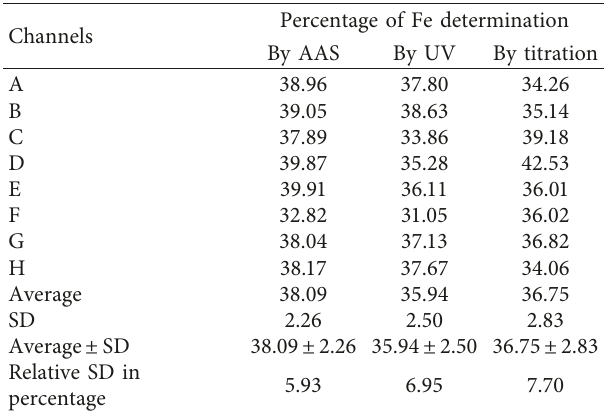
Figure 7: Amount of iron (%) in different samples by three dif- ferent methods. Table 7: A comparison of iron content present in hematite ore by AAS, titration, and UV-spectrophotometric